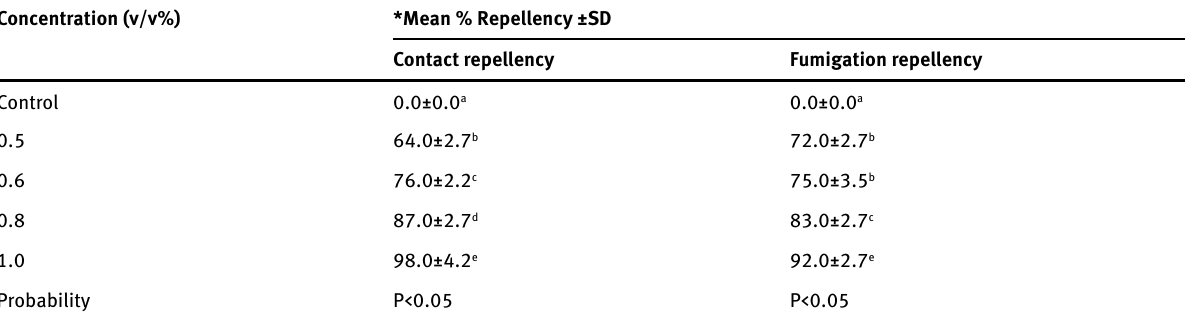
Table 1: Contact and fumigation repellency effect of leaf essential oil of P. dioica on C. maculatus after 2 hour exposure in the contact repel-